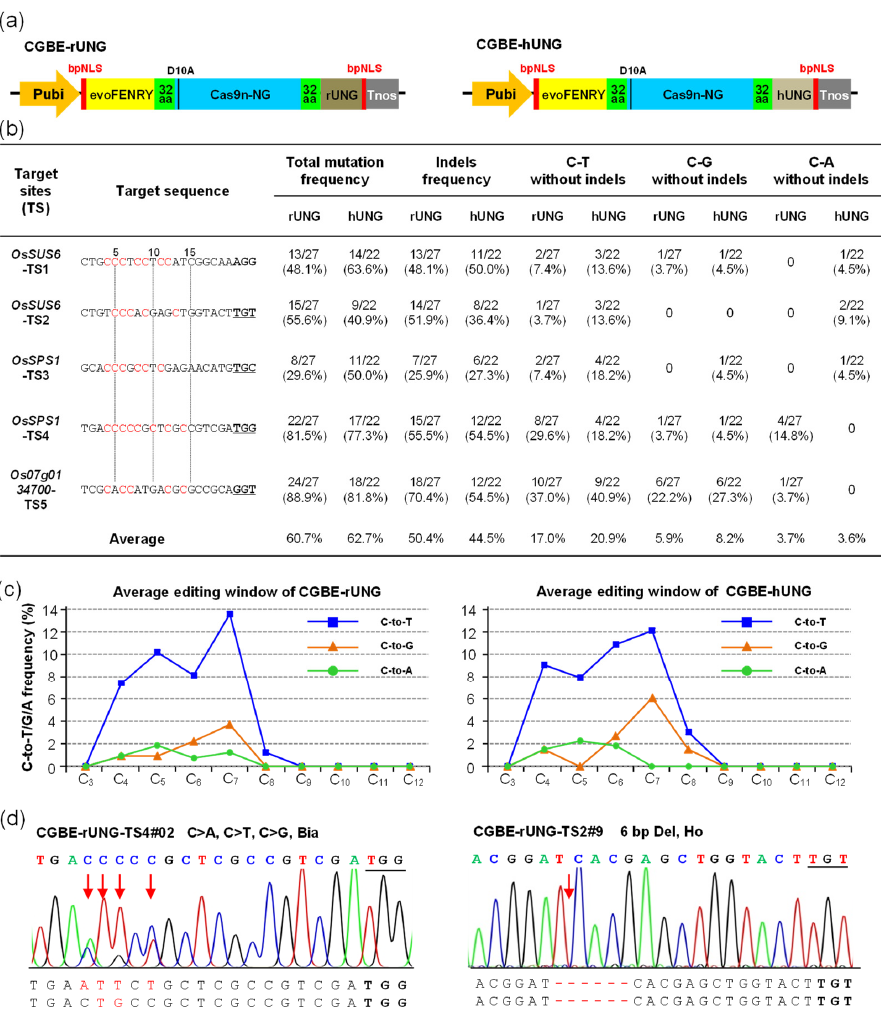
Figure 1. The editing efficiency and mutation types of CGBE-rUNG and CGBE-hUNG in T 0 rice. ( a ) Structures of the CGBE-rUNG and CGBE-hUNG expression cassettes. evoFERNY, a cytosine deaminase with efficient C-T substitution; Cas9n-NG, an SpCas9 variant that recognizes NG-PAM and only has cleavage activity on the target strand; rUNG, uracil N-glycosylase from rice; hUNG, uracil N-glycosylase from humans. ( b ) The efficiency and mutation type of CGBE-rUNG and CGBE-hUNG in T 0 rice, total mutations, and indel frequency were calculated by edited plants/total transgenic positive plants; for C-to-T, C-to-G, and C-to-A substitutions, base substitutions with indel alleles were eliminated. ( c ) The average editing window and editing efficiency of C-to-T/G/A substitution; the 20th base at the 5 ′ end of PAM is numbered C 1 . ( d ) Sanger sequencing chromatogram for some typical mutation types. Bia, biallelic mutation.